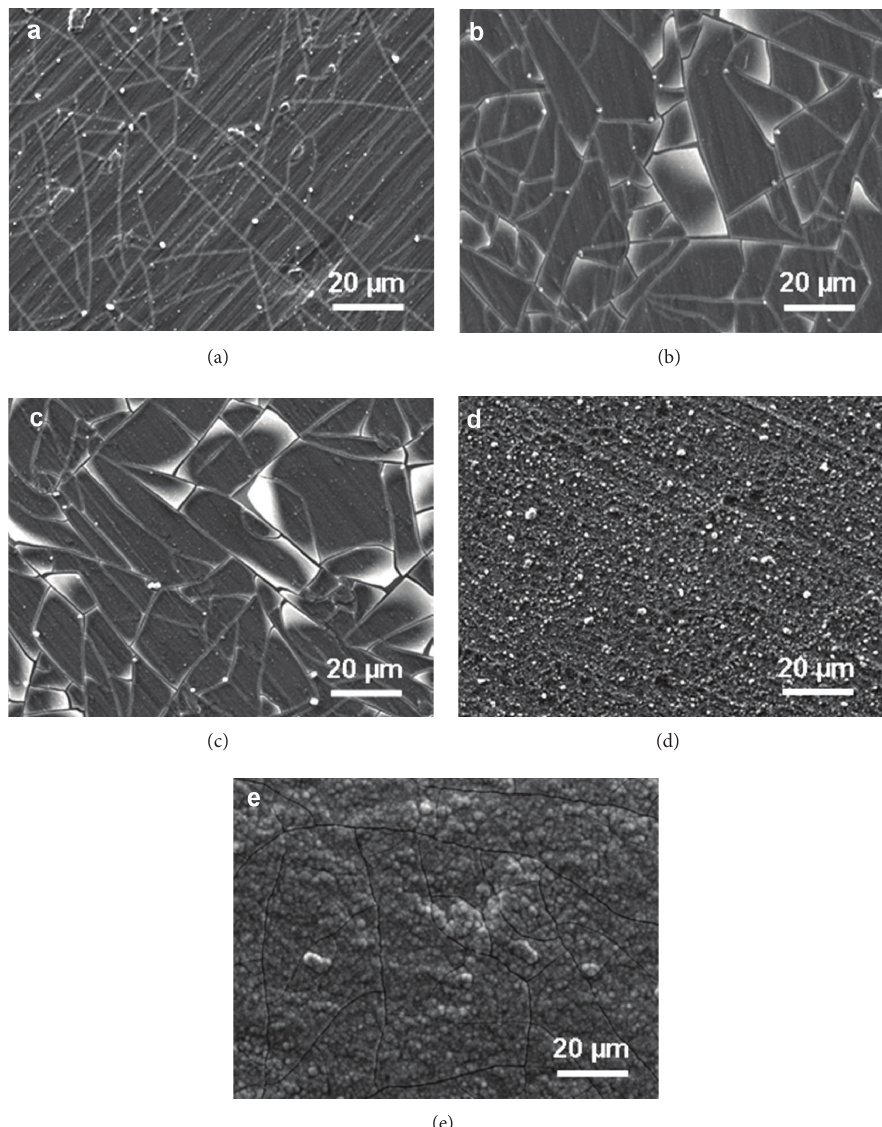
Figure 8: SEM images after immersion in SBF solution for 1 week. Titanium discs with (a) turned surface (TS) and (b)–(d) coated surfaces with 8 nm (TS + 8 nm), 22 nm (TS + 22nm), and P25 (TS + P25) particles. (e) Shows turned surface treated with oxalic acid and diluted hydrofluoric acid (TS + AT-I).